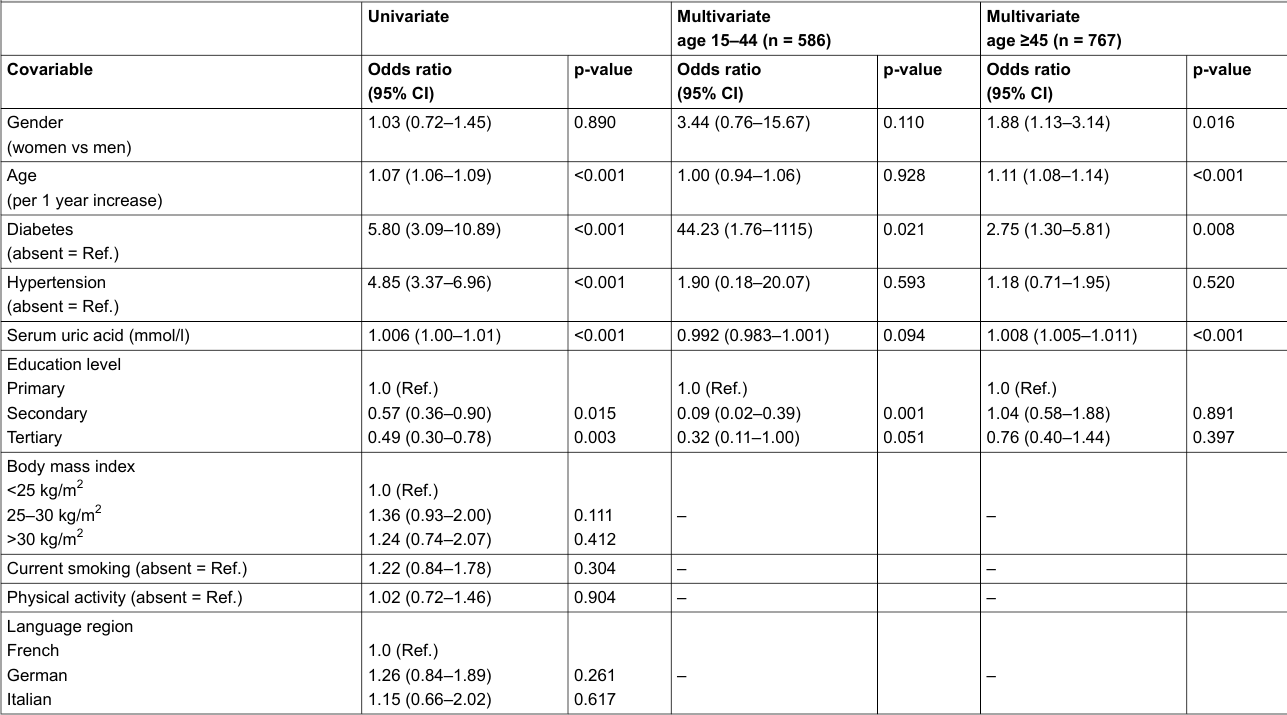
Table 3: Factors associated with chronic kidney disease in univariate and multivariate logistic regression stratified by